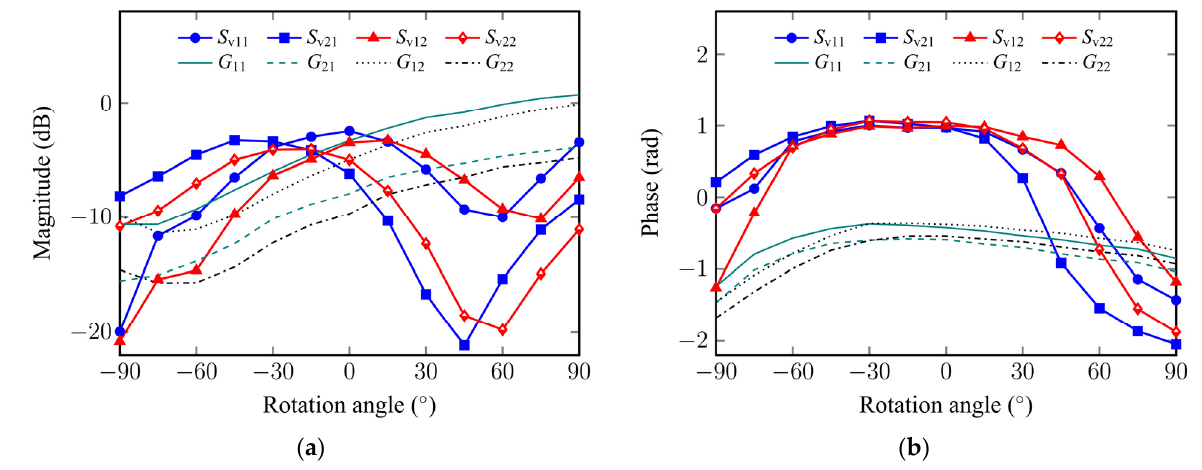
Figure 14. Measured results of the transfer responses for virtual plants and the transfer responses between the virtual microphone locations and the physical microphone locations in the primary field with human head rotation: ( a ) magnitude; ( b ) phase.